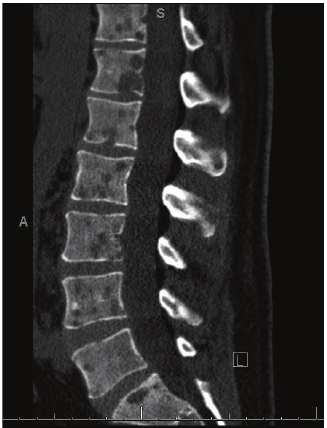
Figure 2: CT lumbar spine without contrast showing innumerable lytic lesions seen throughout the lumbar